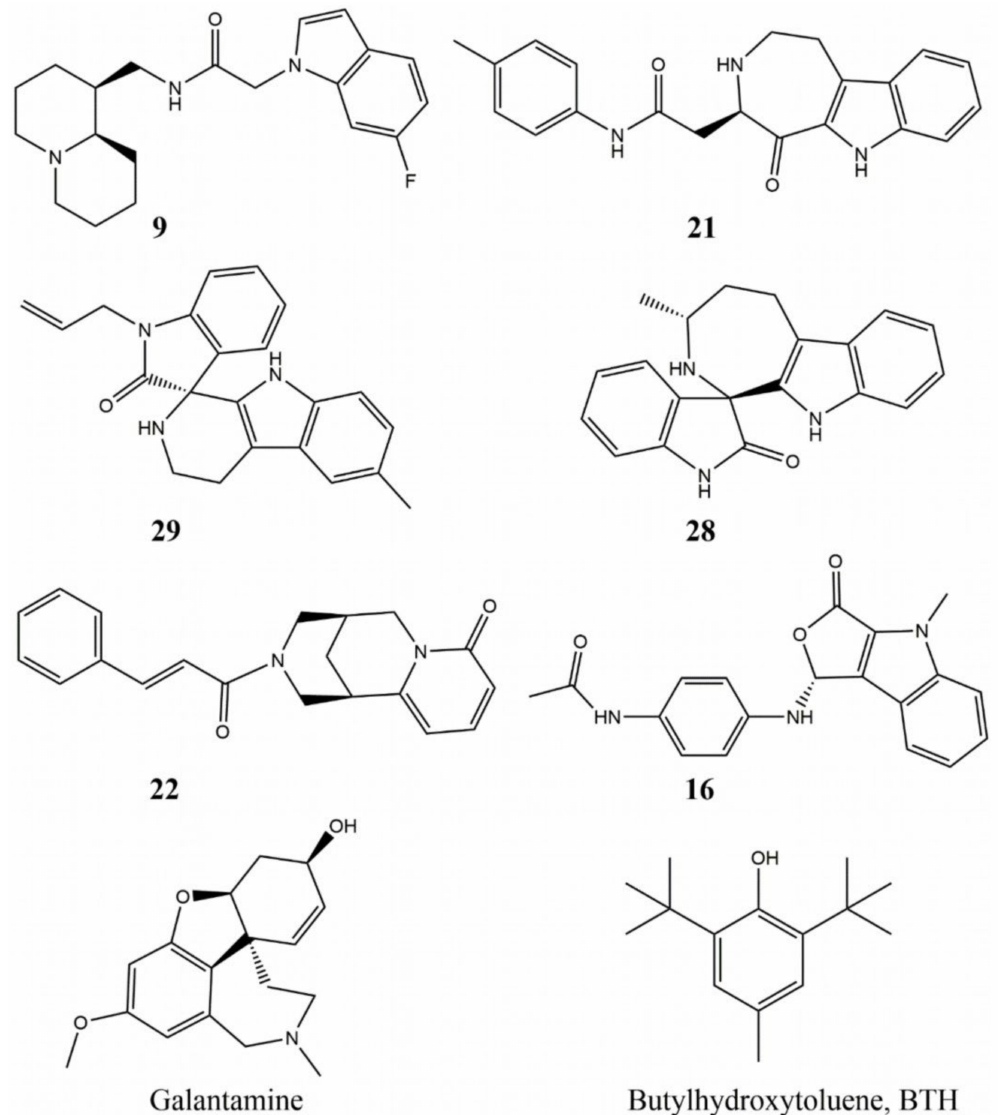
Figure 2. Structures of the novel AChE inhibitors, discovered in the present study: 9 (N-{[(1S,9aR)- octahydro-1H-quinolizin-1-yl]methyl}-2-(6-fluoro-1H-indol-1-yl)acetamide), 21 (N-(4-methylphenyl)- 2-{5-oxo-1H,2H,3H,4H,5H,6H-azepino [4,5-b]indol-4-yl} acetamide), 29 (6 (cid:48) -methyl-1-(prop-2-en-1- yl)-1,2,2 (cid:48) ,3 (cid:48) ,4 (cid:48) ,9 (cid:48) -hexahydrospiro[indole-3,1 (cid:48) -pyrido [3,4-b]indol]-2-one), 28 (3-methyl-1 (cid:48) ,2 (cid:48) ,3,4,5,10- hexahydro-2H-spiro[azepino [3,4-b] indole-1,3 (cid:48) -indol]-2 (cid:48) -one), 22 ((1S,9R)-11-[(2E)-3-phenylprop-2- enoyl]-7,11-diazatricyc lotrideca-2,4-dien-6-one), 16 ((R)-N-(4-((4-methyl-3-oxo-3,4-dihydro-1H-furo [3,4-b] indol-1-yl) amino)phenyl)acetamide), and the two positive controls —galantamine (GAL) and butylhydroxytoluene